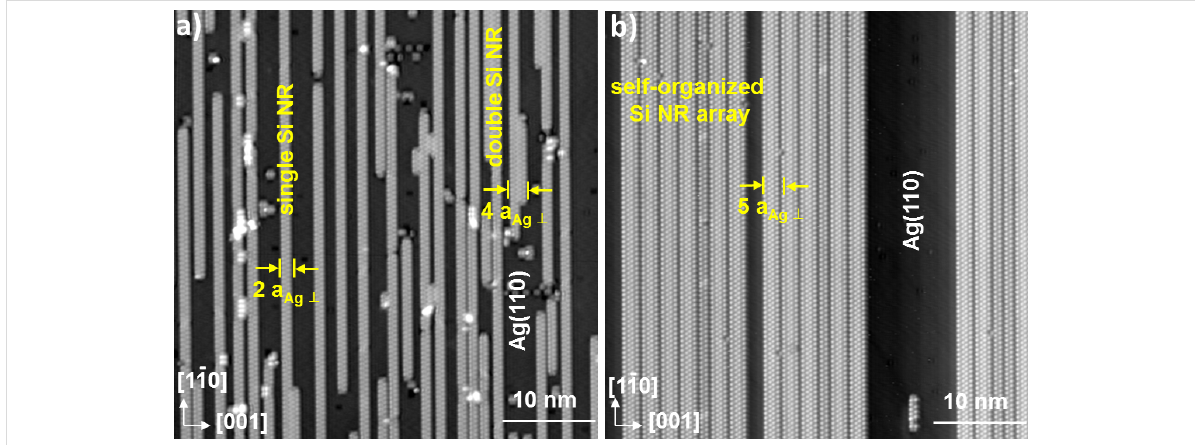
Figure 1: STM images recorded at 77 K at submonolayer Si coverage showing single and double Si nanoribbons (NRs) grown on Ag(110) upon Si deposition at (a) T sub = RT, I = 300 pA, V sample = 1V and (b) T sub = 460 K, I = 200 pA, V sample = 140 mV. The pitch of the Si array is 5 ∙ ( = 0.409 nm, the Ag(110) lattice parameter in the [001]